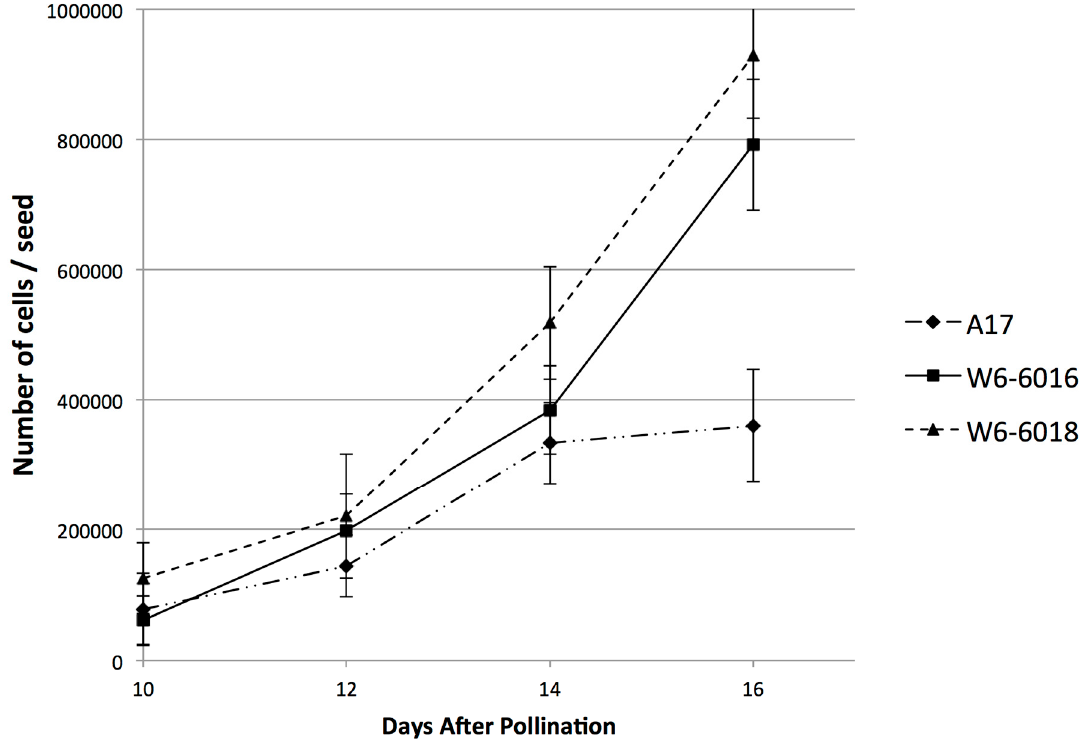
Figure 4. Cell proliferation during 10–16 DAP of seed development. Average total number of cells calculated to be present in a single seed of each of the accessions: A17 ( diamonds ), W6-6016 ( squares ) and W6-6018 ( triangles ). Standard deviations are indicated.